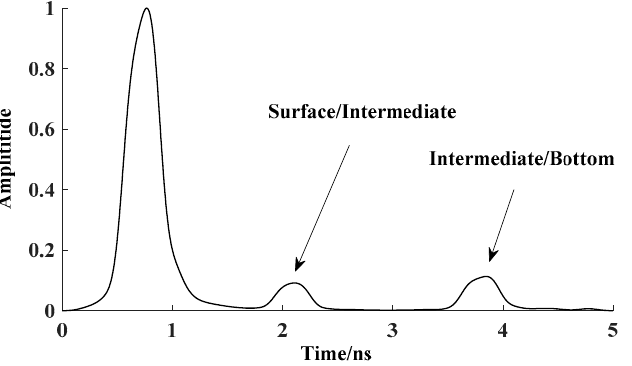
Figure 2. The detected layers of single-channel wave using Hilbert algorithm.